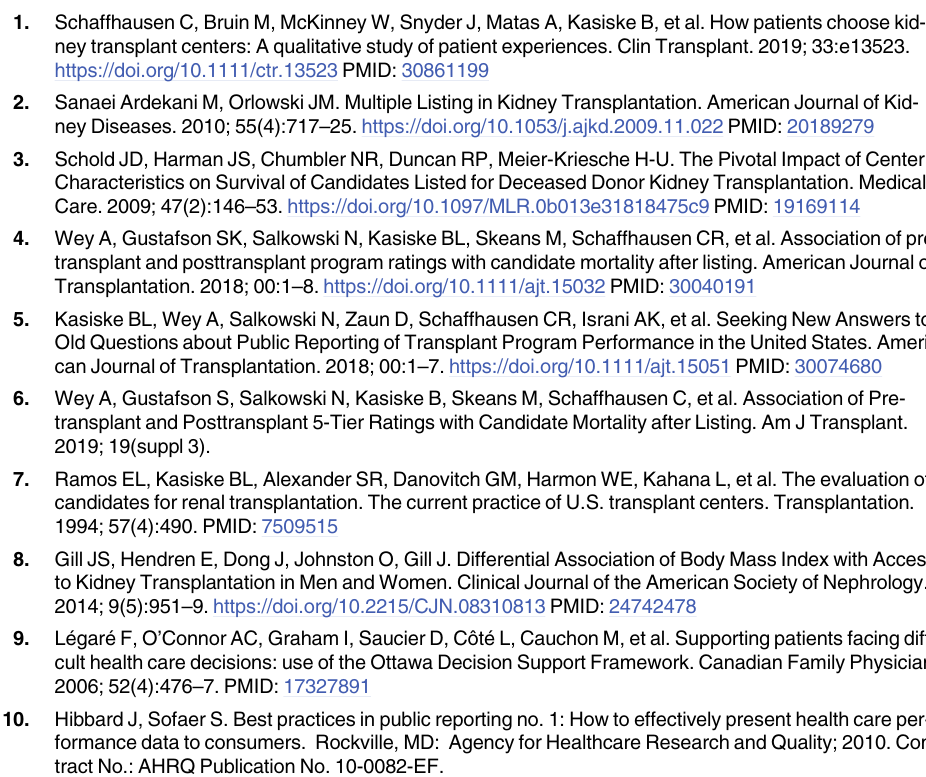
S4 Table. Selection of feedback from website users not enrolled in